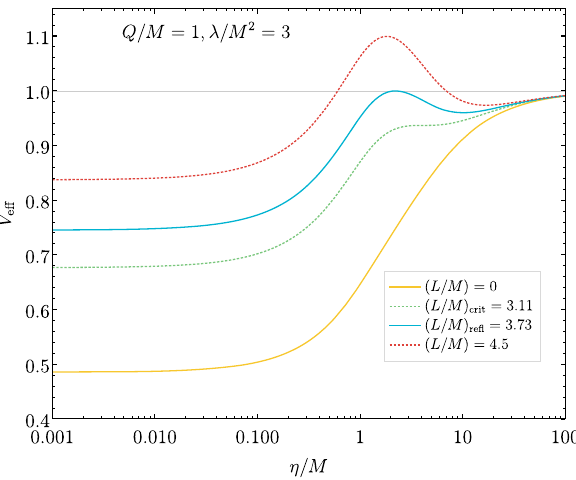
Fig. 25 V eff vs η/ M for massive particles ( κ = − 1) for a selection